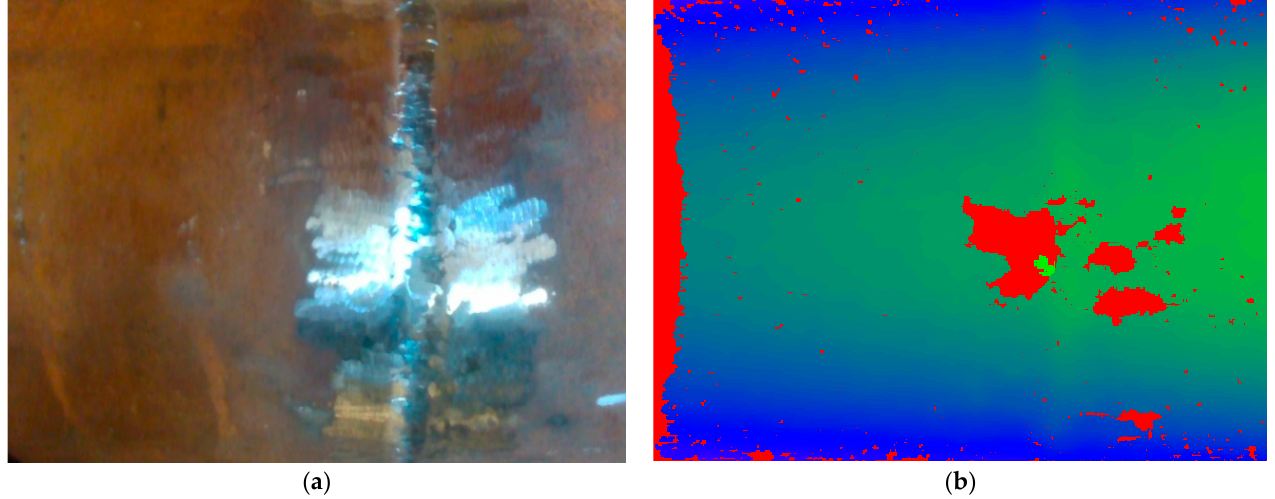
Figure 6. A sample pair of images in the collected dataset: ( a ) an RGB image; ( b ) a corresponding depth image.